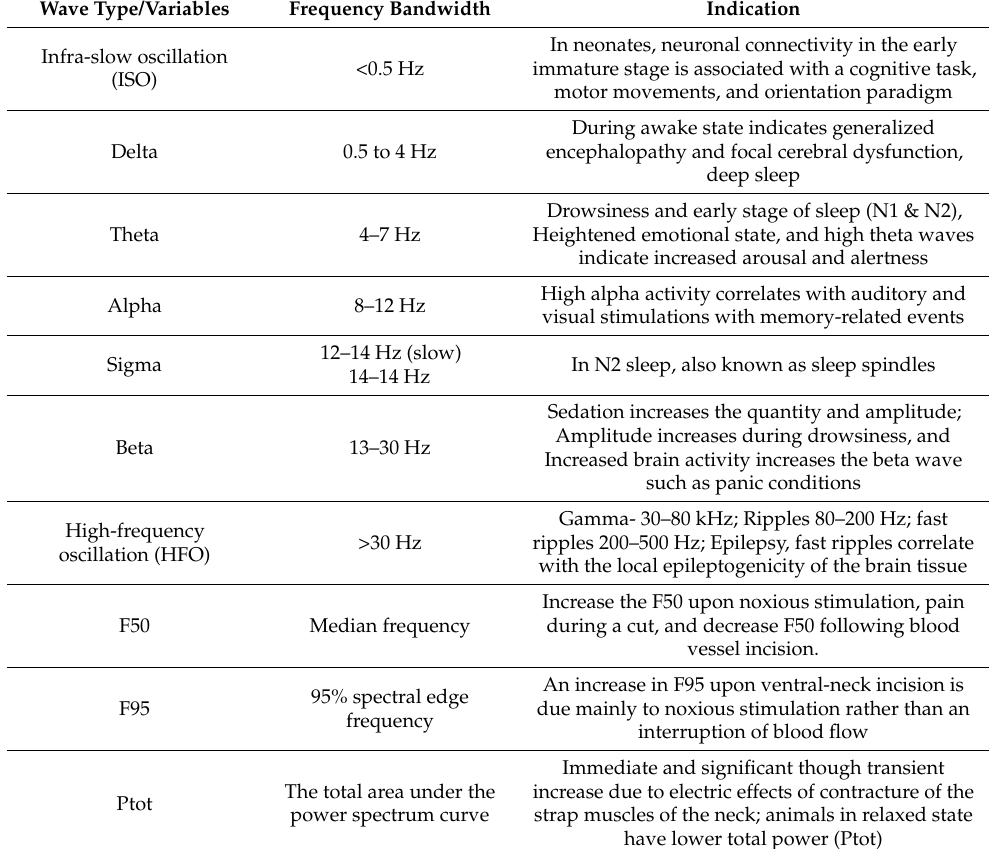
Table 1. Characterization of the EEG